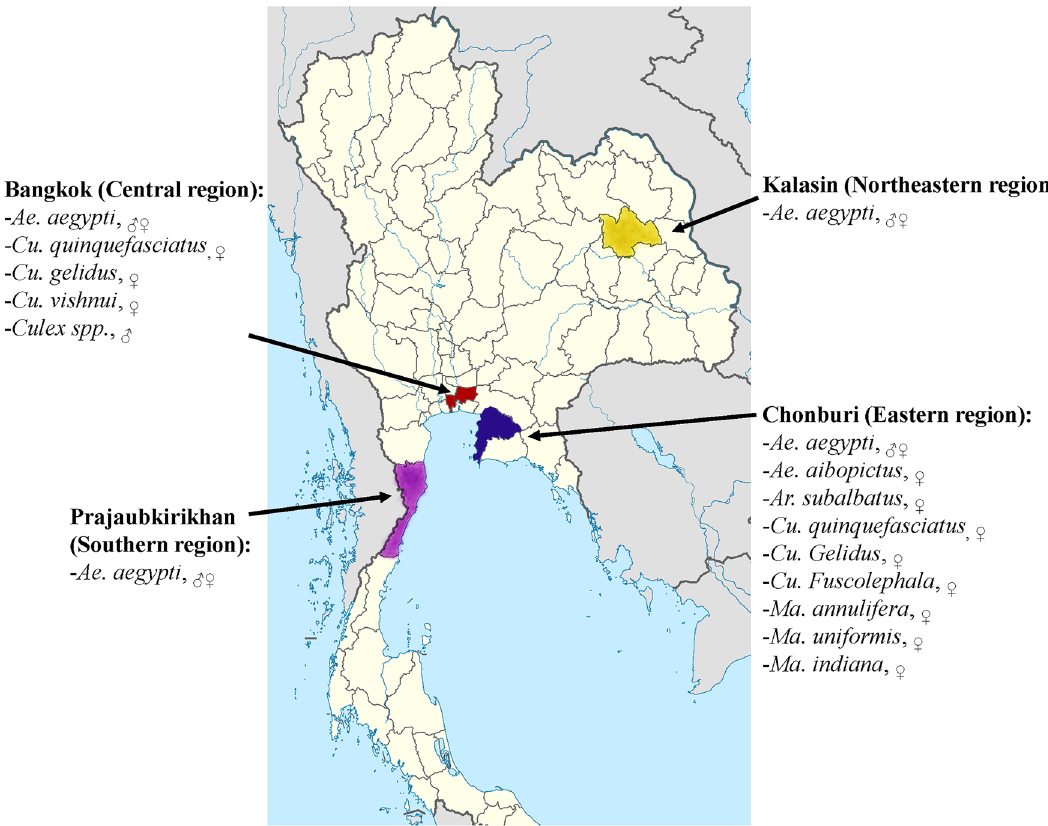
Figure 1. Study sites used for the sample collection. The map was originally obtained from https ://uploa d.wikim edia.org/wikip edia/commo ns/a/ab/Thail and_Bangk ok_locat or_map.svg with license https ://creat iveco mmons .org/licen ses/by/3.0/deed.en and was modified by using free version of Adobe Illustrator CC 2017